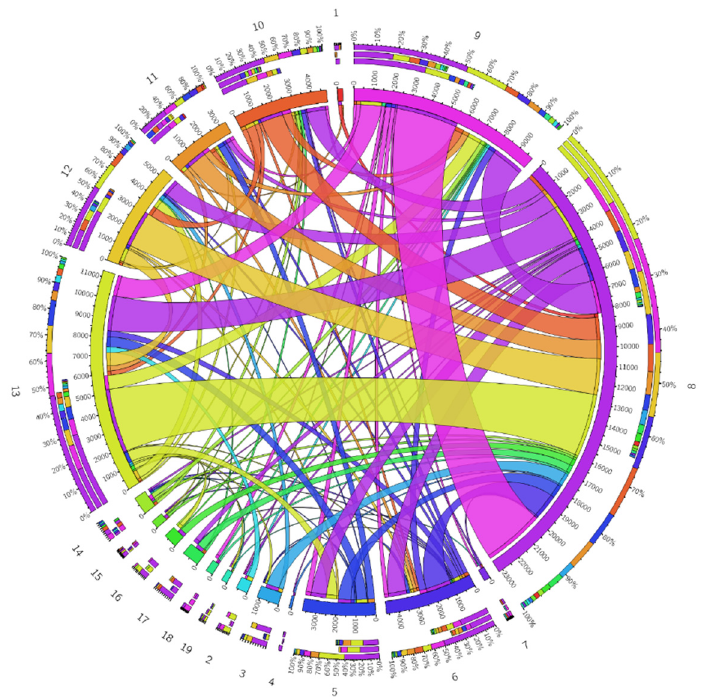
Figure A1. Relation between microstates of video 1. The figure shows each relation between mi- crostates, their time lapse in the record and how many relations